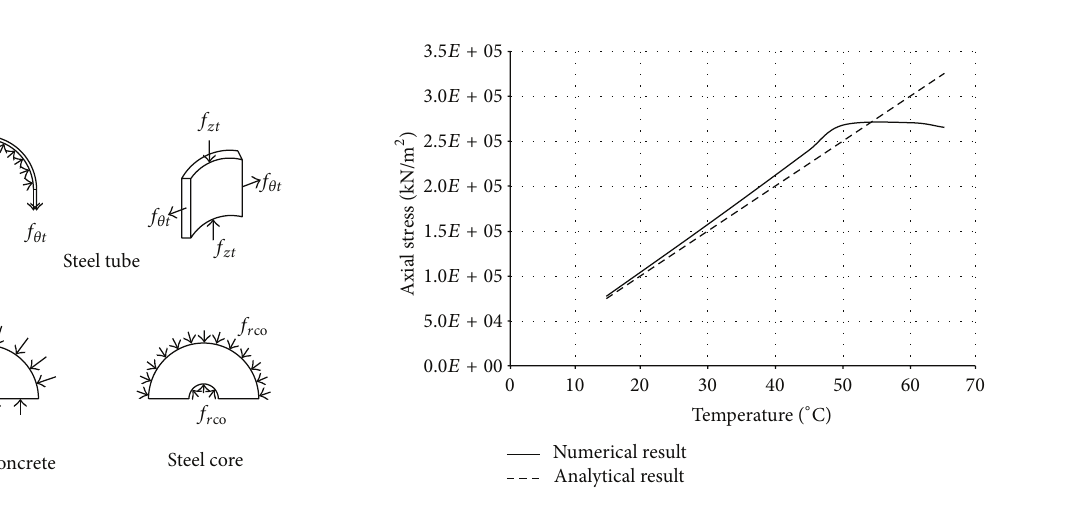
Figure 13: Comparison of axial stress in steel core.